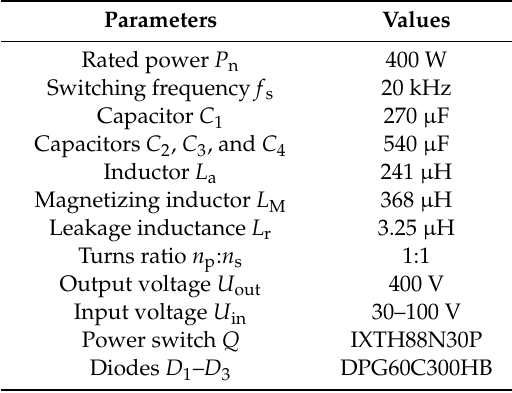
Figure 6. The experimental prototype of the proposed converter. Table 2. Experiment parameters.